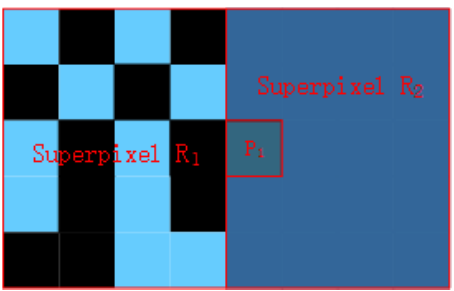
Figure 2. Disadvantage of using mean color to describe the color distribution of superpixels. Superpixel R 1 is composed of pixels whose RGB is (0,0,0) or (102,204,254), and the mean color is (51,102,127). The RGB of pixels in superpixel R 2 is (51,102,153). The RGB of pixels in region P 1 is (51,102,127). Red lines are boundaries of superpixels or